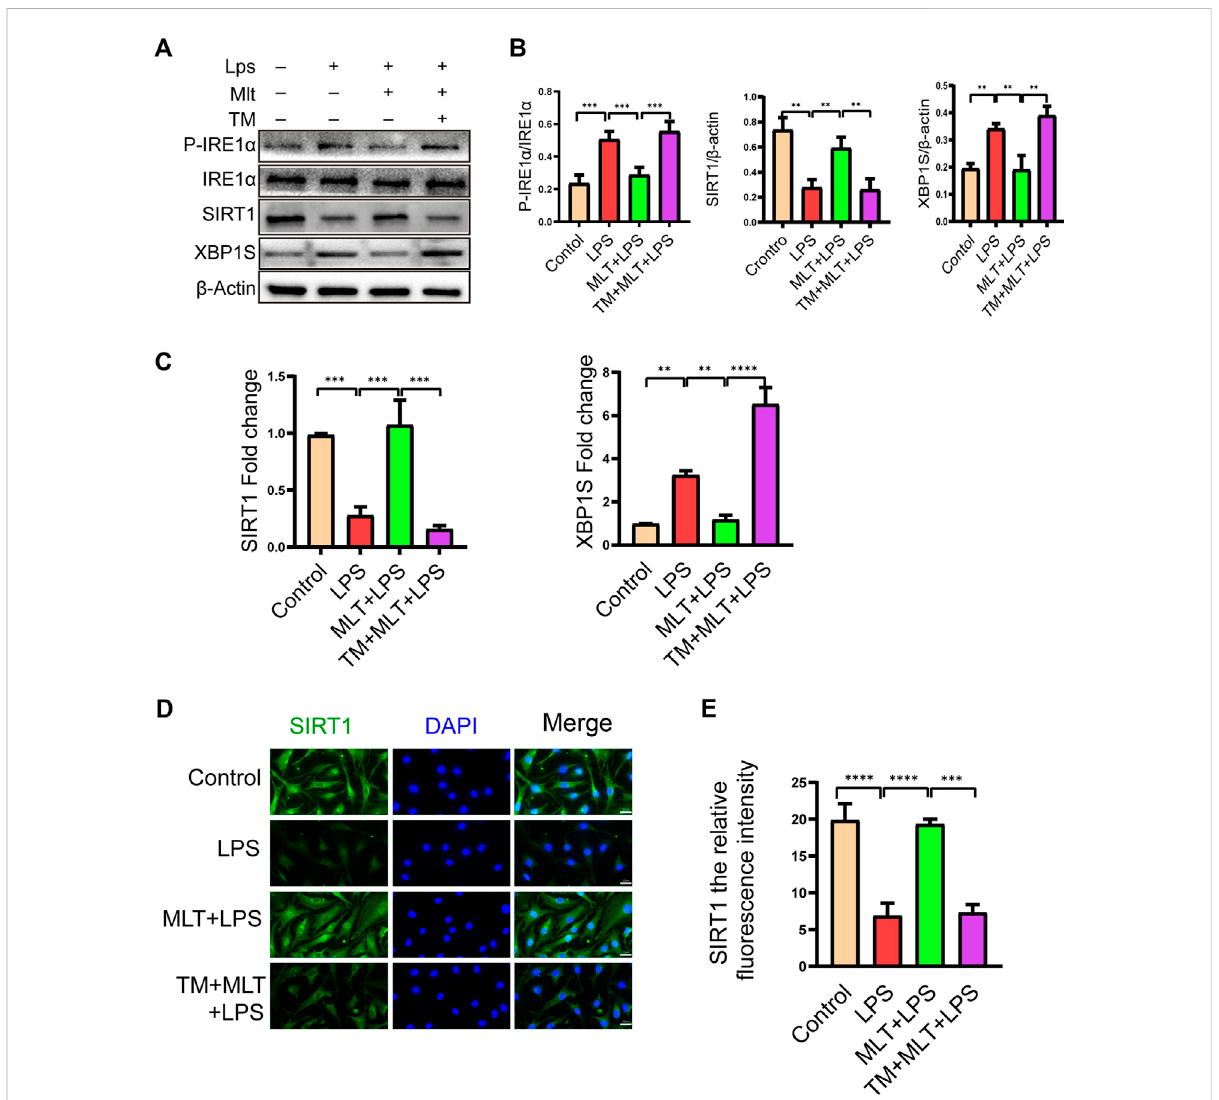
FIGURE 4 Melatonin upregulated the expression of sirtuin 1 (SIRT1) and attenuated the activation of the inositol – requiring enzyme 1 α – X – box – binding protein1 (IRE1 α – XBP1S)pathway. (A,B) The proteinexpression levels of SIRT1 and P -IRE1 α , P -IRE1 α and XBP1S proteinsweredetermined bywestern blot analysis. (C) We evaluated the messenger RNA expression level of SIRT1 and XBP1S by real – time polymerase chain reaction analysis. (D,E) SIRT1 immuno fl uorescence staining and quanti fi cation of the number of SIRT1 – positive human chondrocytes in different groups. The experiment was repeated three times independently. Signi fi cantly increased green spots indicate that SIRT1 protein expression is upregulated (bar, 20 μ m). All values are shown as the mean ± standard deviation. ** p < 0.01, *** p < 0.001, **** p < 0.0001. Abbreviation: ns, not signi fi